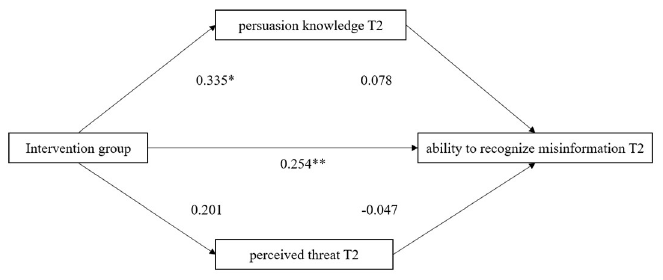
Figure 5. Mediation effect of persuasive knowledge and perceived threat. ** p < 0.01; * p < 0.05.